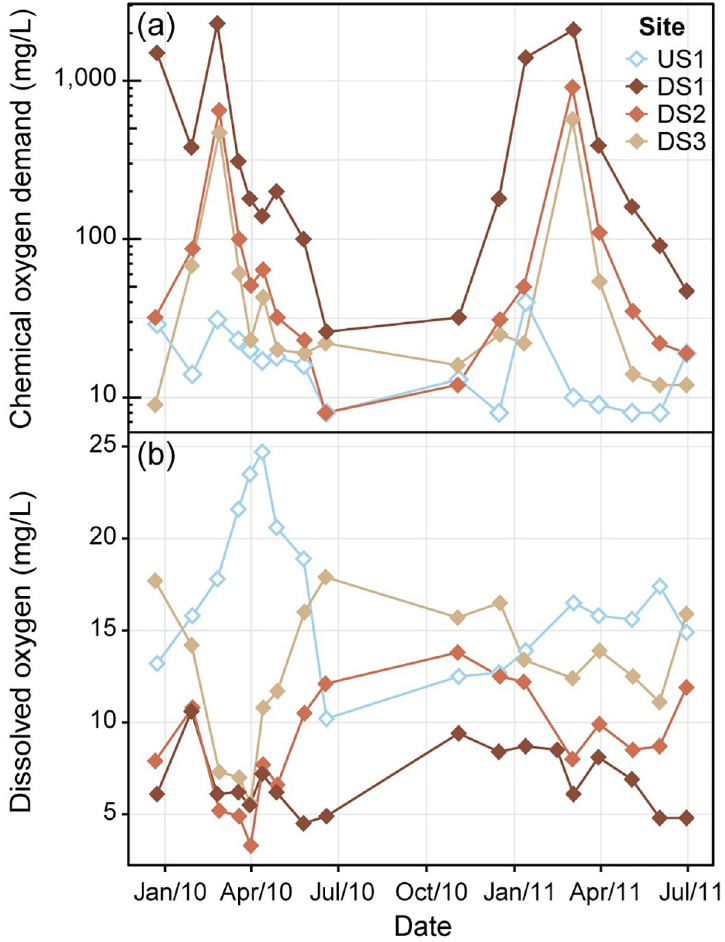
Fig 3. Water-quality results for grab samples collected during biofilm field investigations. (a) chemical oxygen demand (COD) concentrations (left-censored values graphed at the reporting limit (of 8 mg/L)) and (b) dissolved oxygen (DO)